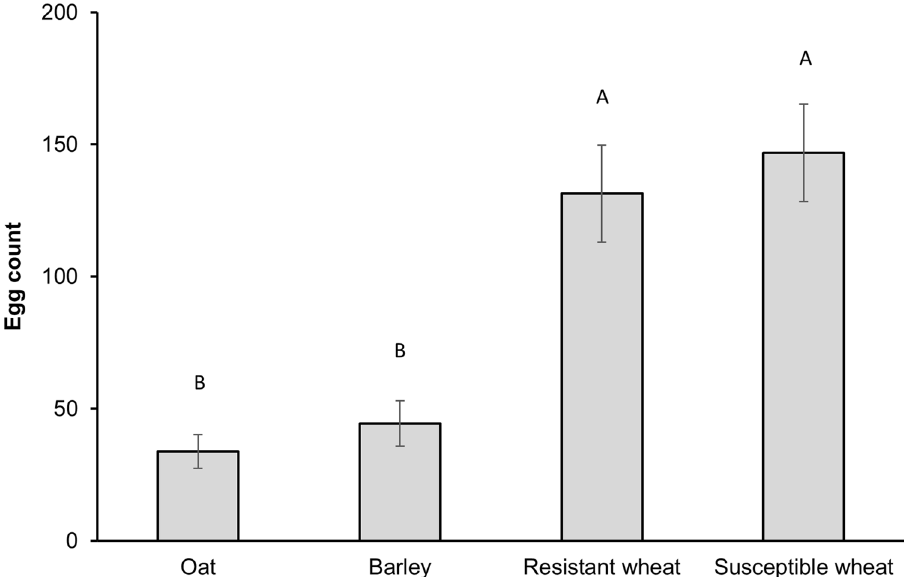
Figure 1. Oviposition (number of eggs per plant) by a single mated female on each host plant treatment in a choice test. Error bars represent standard errors (± SE). Oat (cv. Cayuse); Barley (cv. Champion); Resistant wheat (cv. Hollis); Susceptible wheat (cv. Alturas).